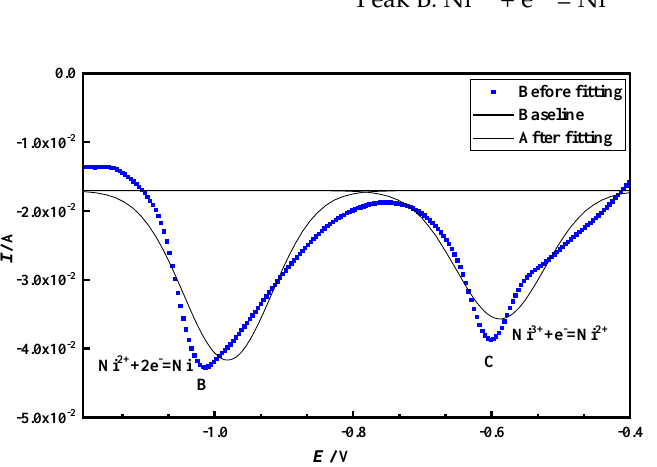
Figure 6. Peak shape fitting diagram of square wave voltammogram of LiNiO 2 in NaCl-CaCl 2 molten salt under 30 Hz condition.